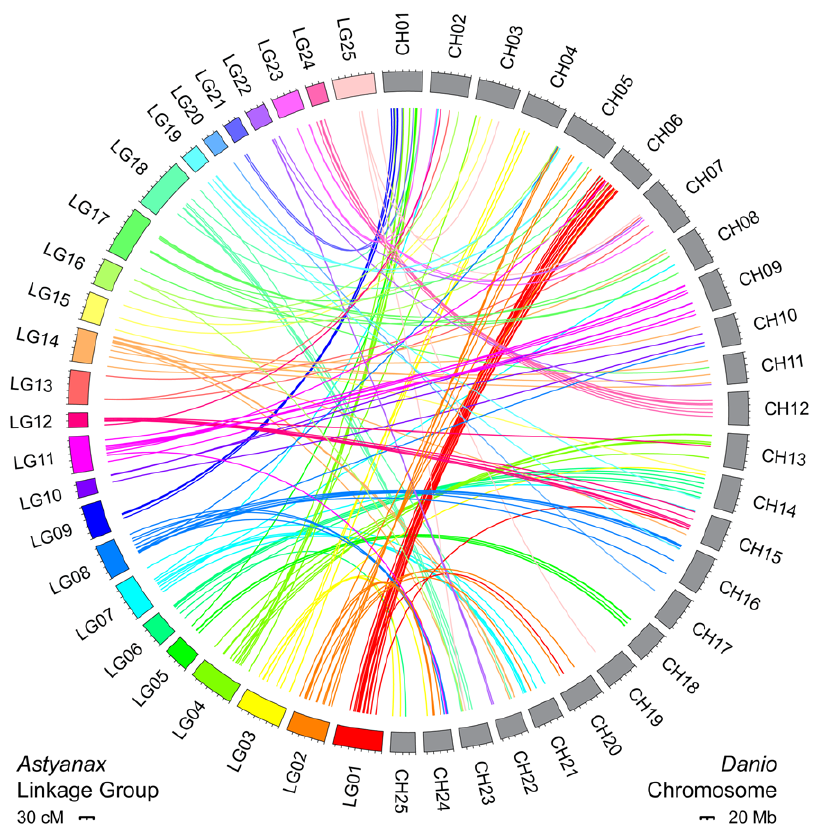
Figure 2. Comparative mapping of the Astyanax and zebrafish genomes. Colored boxes represent Astyanax linkage groups 1 2 25; grey boxes represent zebrafish ( Danio rerio ) chromosomes 1–25. Colored lines link genetic markers from Astyanax to their BLAST position in zebrafish. Circle plot created with Circos [37].